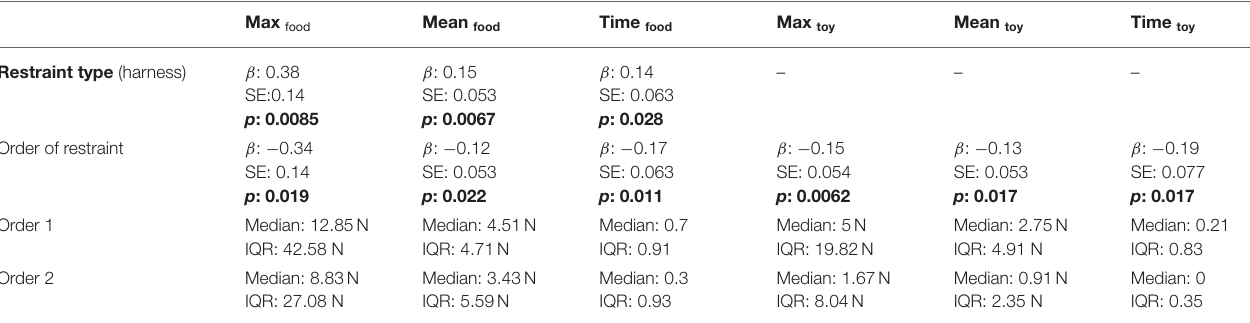
TABLE 3 | Linear mixed-effects model of the effects of restraint types and the order of restraint types used on leash tension and pulling time. Max food Mean food Time